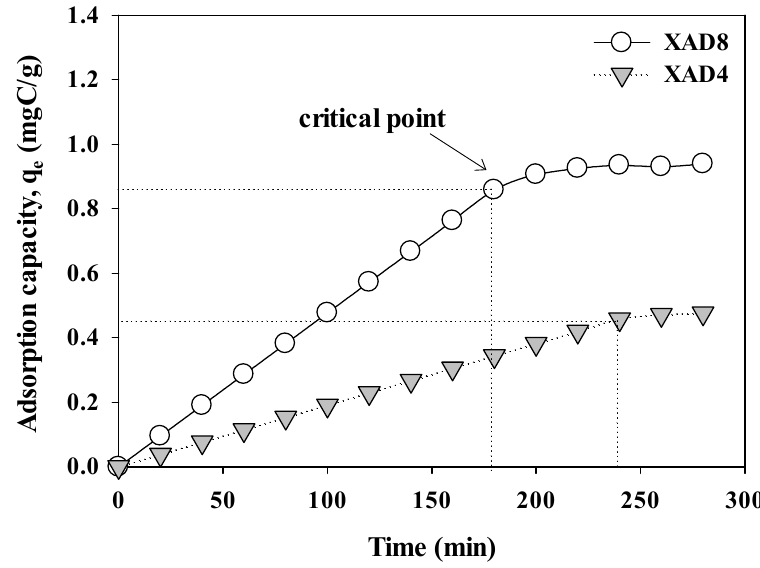
Figure 2. Adsorption capacity ( q e ) of XAD 8/4 resins for Aldrich humic acid (AHA).